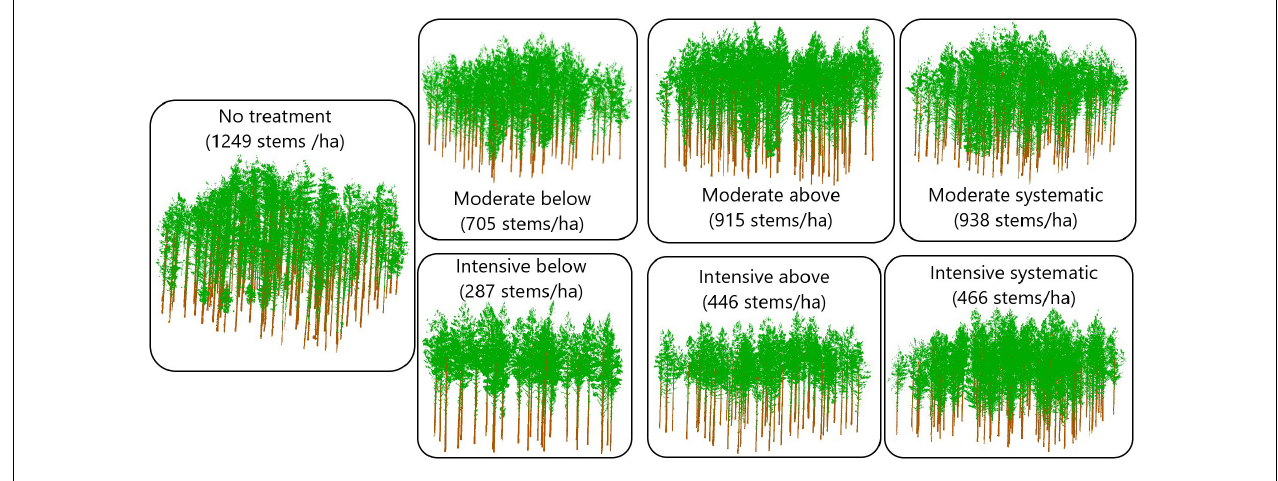
FIGURE 2 | Schematic representation of the effects of silviculture treatments on stand density based on TLS data collected in October 2018.